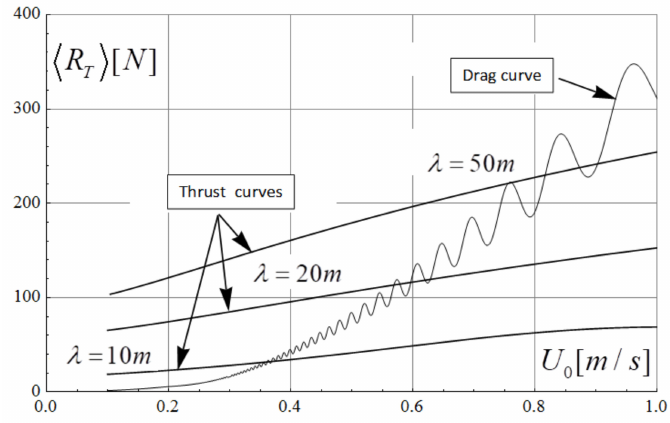
Figure 11. Calculation of the speed and thrust of the WG (moderate and large wave